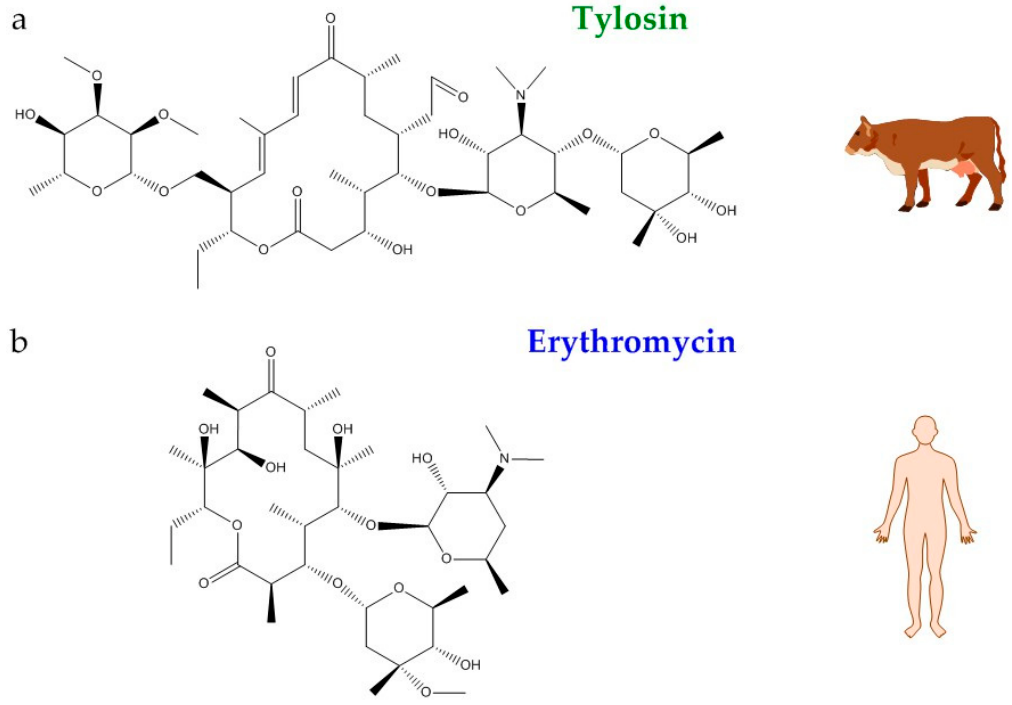
Figure 2. Molecular structure of ( a ) Tylosin, an antibiotic used in husbandry; ( b ) Erythromycin, an antibiotic used for human beings.